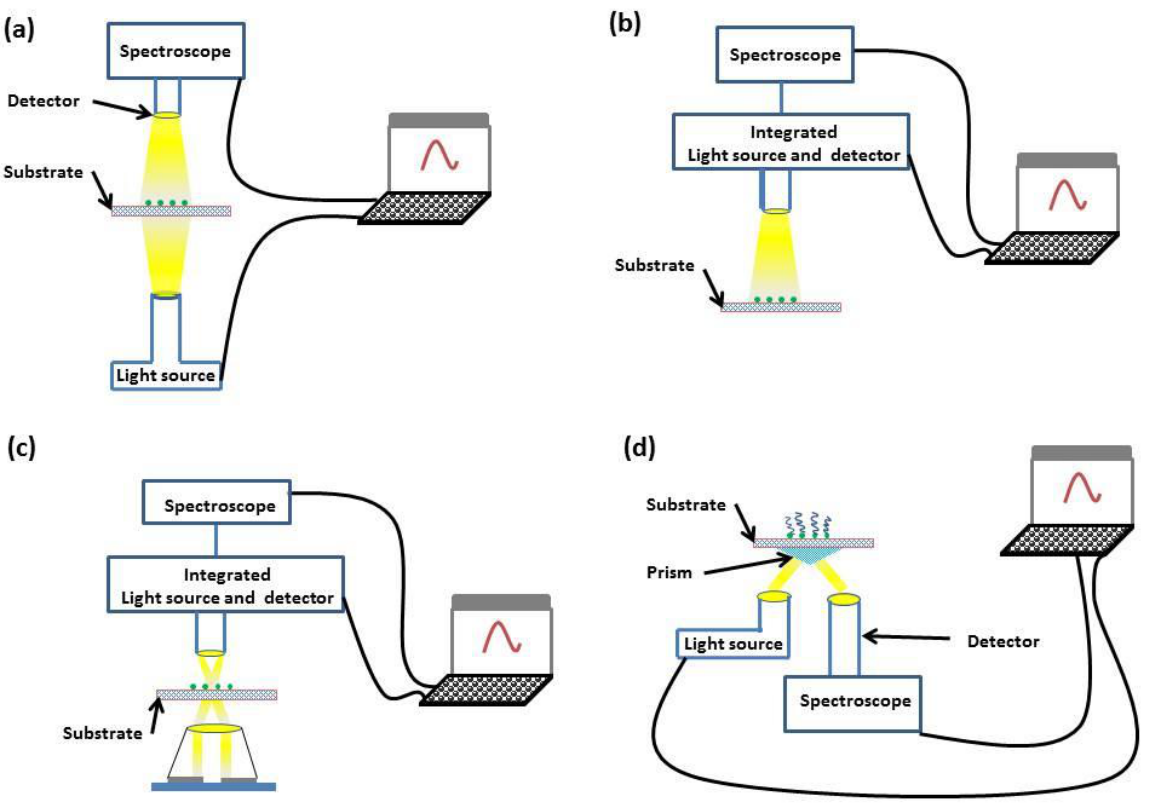
Figure 3. Diagrams of transmission ( a ), reflection ( b ), dark-field scattering ( c ) and TIR ( d )